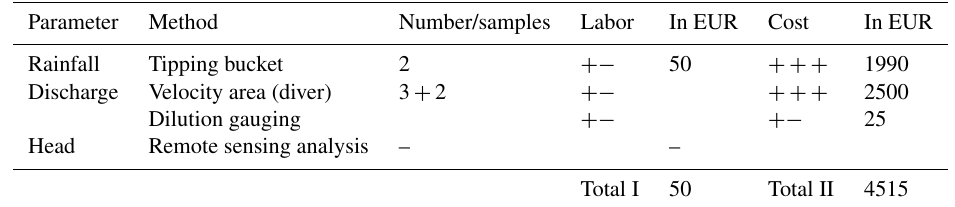
Table A9. Indonesia case, scenario 3: to investigate discharges of four other rivers. Parameter Method Number/samples